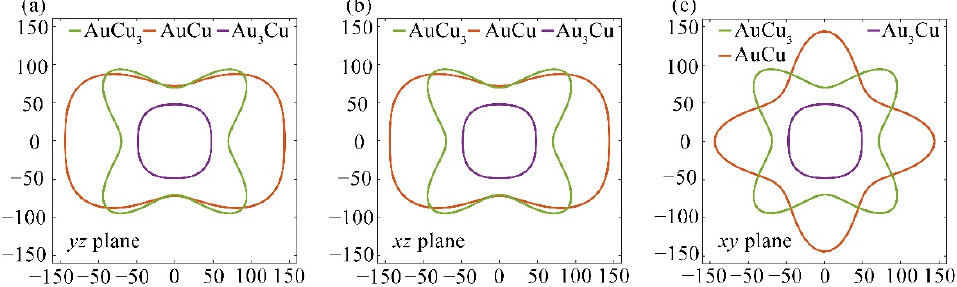
Figure 2. Directional dependence of Young’s moduli: ( a ) Young’s modulus of AuCu 3 ; ( b ) Young’s modulus of AuCu; ( c ) Young’s modulus of Au 3 Cu.